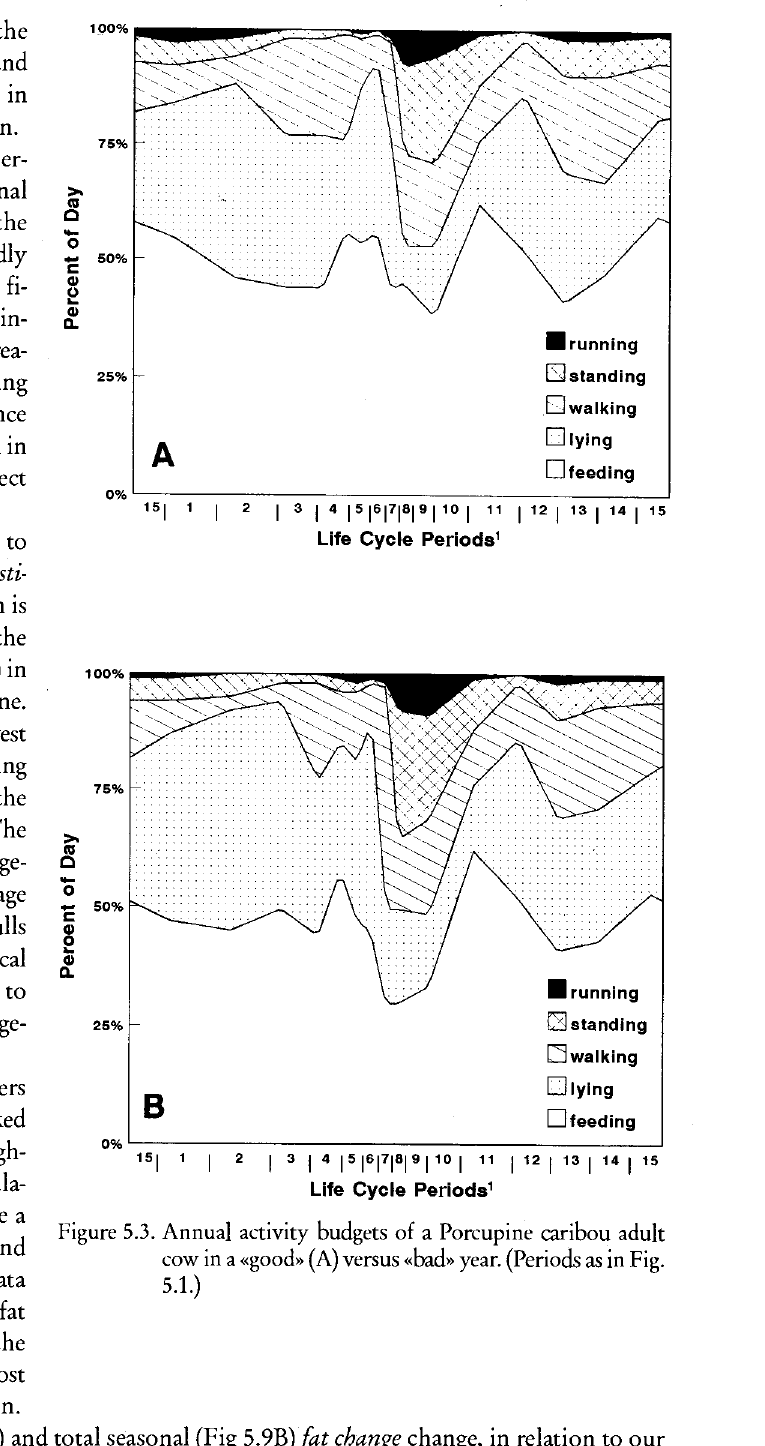
Figure 5.3. Annual activity budgets of a Porcupine caribou adult cow in a «good» (A) versus «bad» year. (Periods as in Fig.